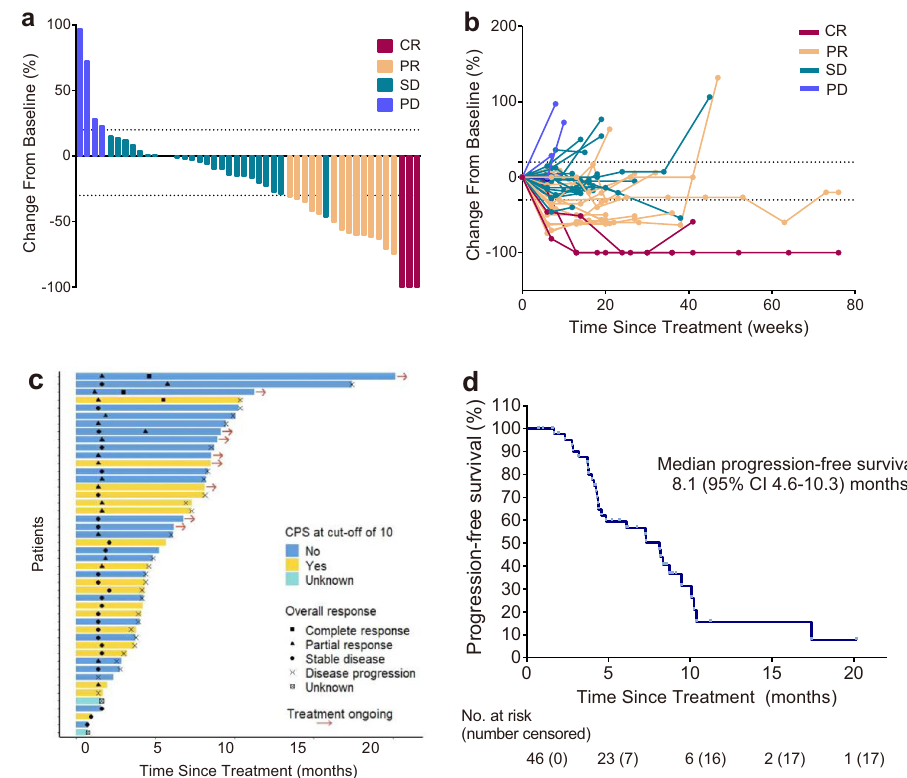
Fig. 2 Ef fi cacy evaluation. a Waterfall plot of best percent change in tumor size from baseline in the ef fi cacy-evaluable population ( n = 44). b Changes in tumor burden from baseline in the ef fi cacy-evaluable population ( n = 44). c Swimmer plot of duration of treatment ( n = 46). d Kaplan – Meier curves of PFS ( n = 46). Source data are provided as a Source Data fi